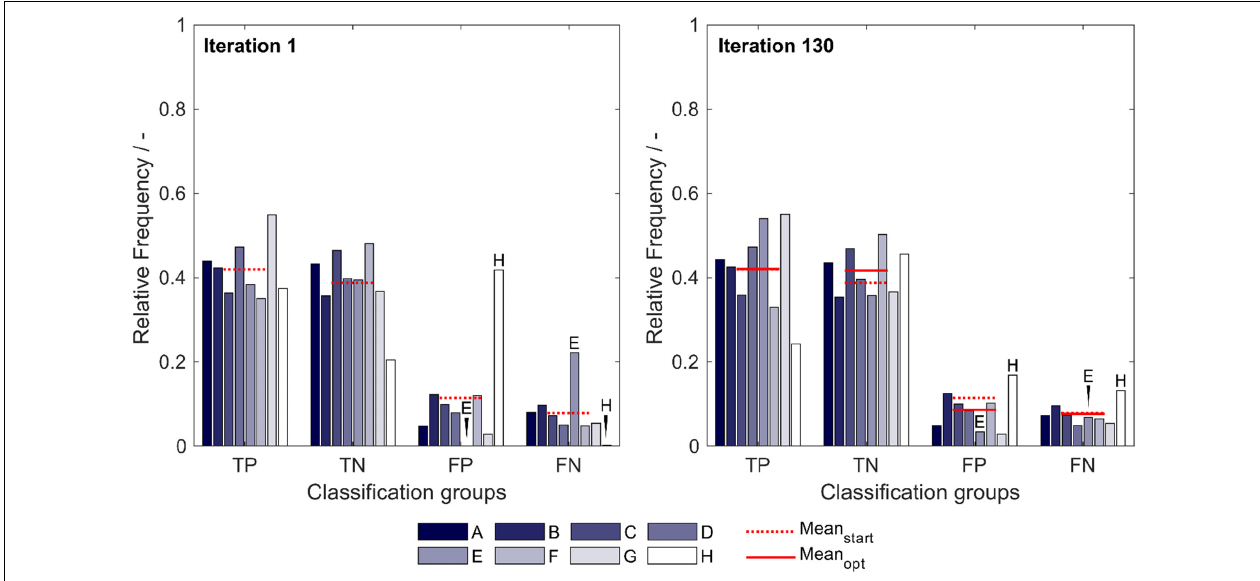
FIGURE 2 | Relative frequency of classification groups based on insertion strategies (A–H) in the first iteration (left) and the best optimization iteration (right) during insertion strategy-based optimization with the 91 literature scales. The mean of the relative frequencies within a classification group is shown for the first iteration (Mean start ) and for the best optimization (Mean opt ), indicating that through optimization, the FP group decreases in mean relative frequency while the TN group increases in mean relative frequency. Strategies E and H are marked additionally to guide the eye. TP: true positive; TN: true negative; FP: false positive; and FN: false